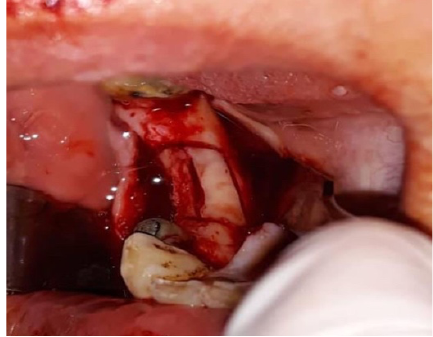
Figure 5. The bone fragments.